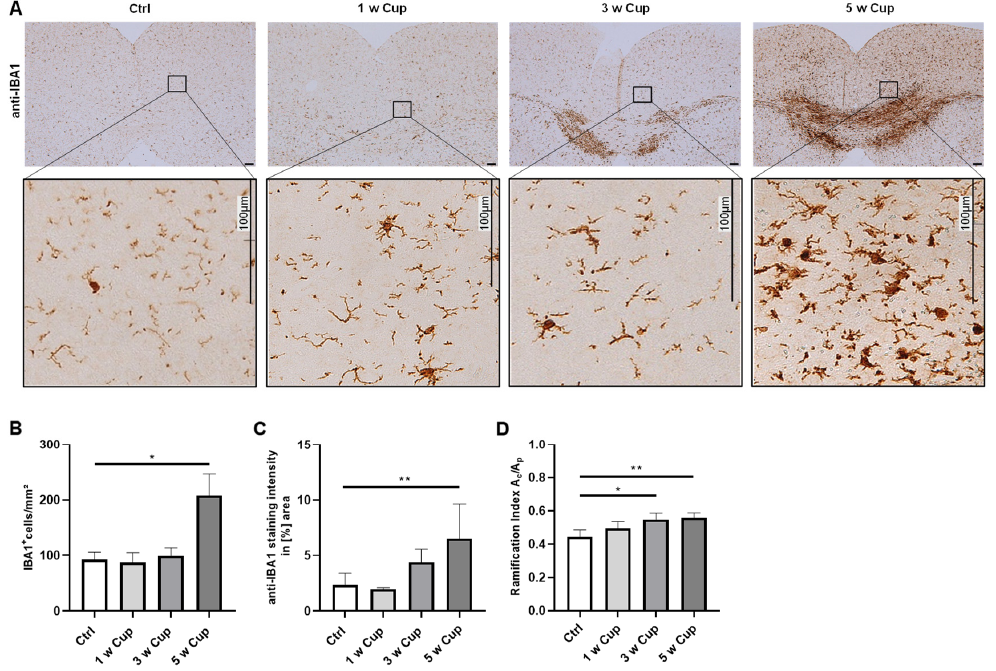
Figure 3. Microglia activation in the medial retrosplenial cortex of cuprizone-intoxicated mice (n = 5 per group). ( A ) Representative anti-IBA1 staining of control (Ctrl), 1, 3, and 5 w Cup mice. Insets